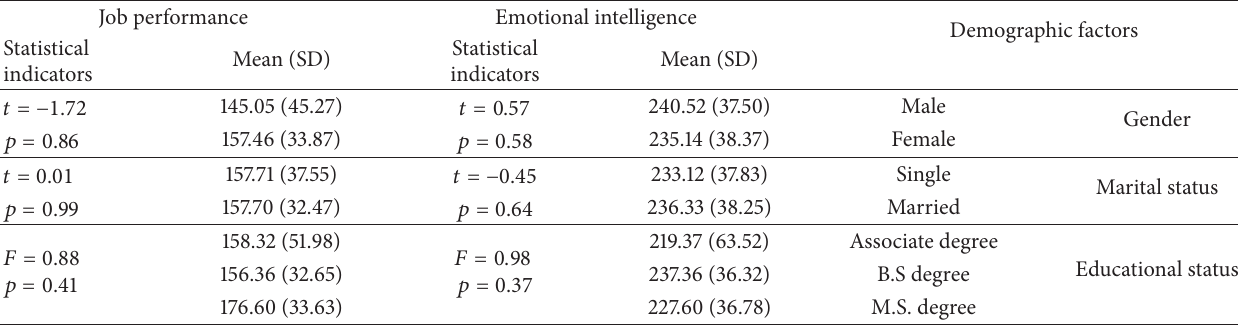
Table 2: Relationship between demographic factors with perception of job performance and nurses’ emotional